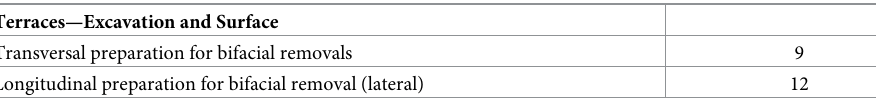
Table 11. Bifaces retaining distinct preparation